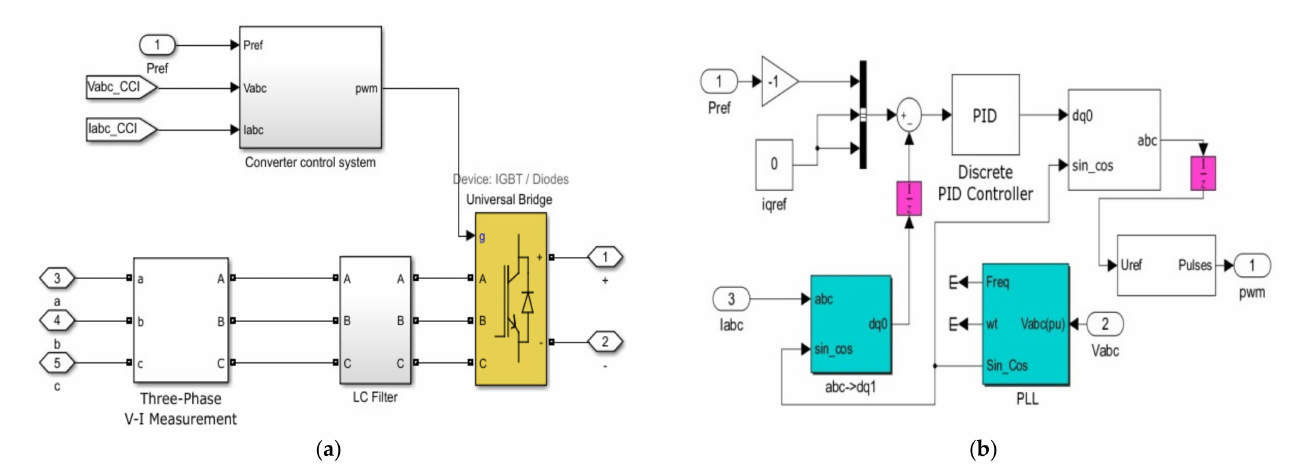
Figure 3. ( a ) Block diagram of a power converter with BESS. ( b ) Control scheme of current-controlled inverter.